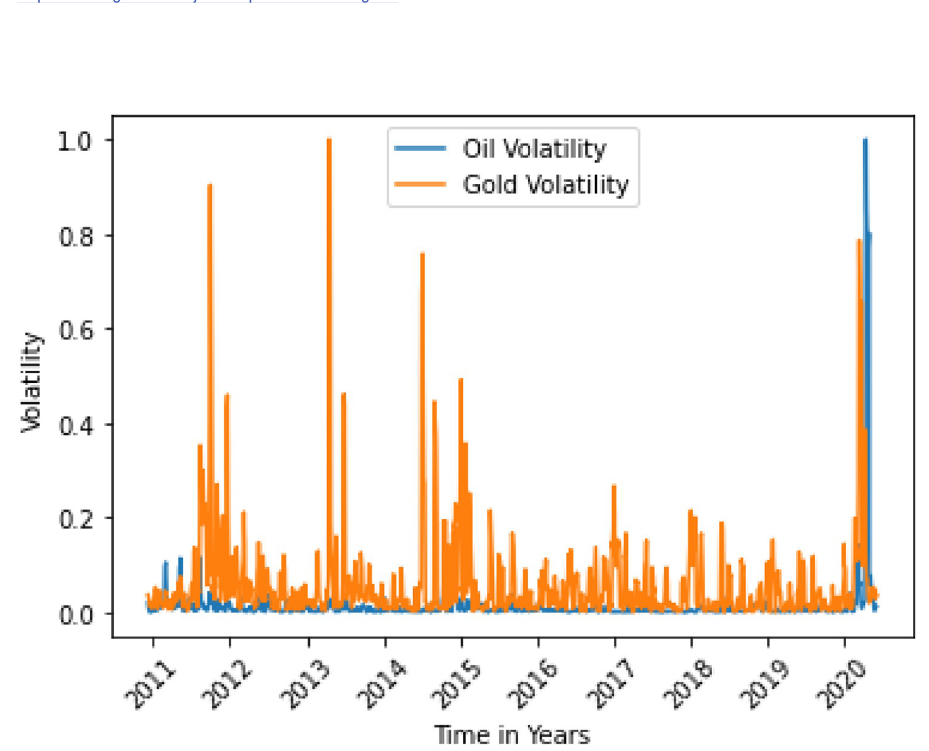
Fig 8. Gold variance Granger causes oil variance after 6 lags. Here, the correlation between two data is 0.0653.